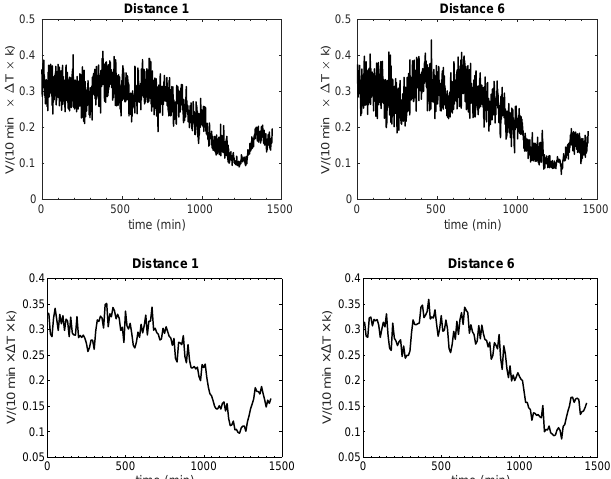
Figure 5. LiDAR measurements obtained upstream the wind turbine (right side) at distances 1 ( left ) and 6 ( right ). Top: raw measurements. Bottom: measurements promediated every 10 min. (Herein and in what follows, all the velocity fields are escaled with a factor k